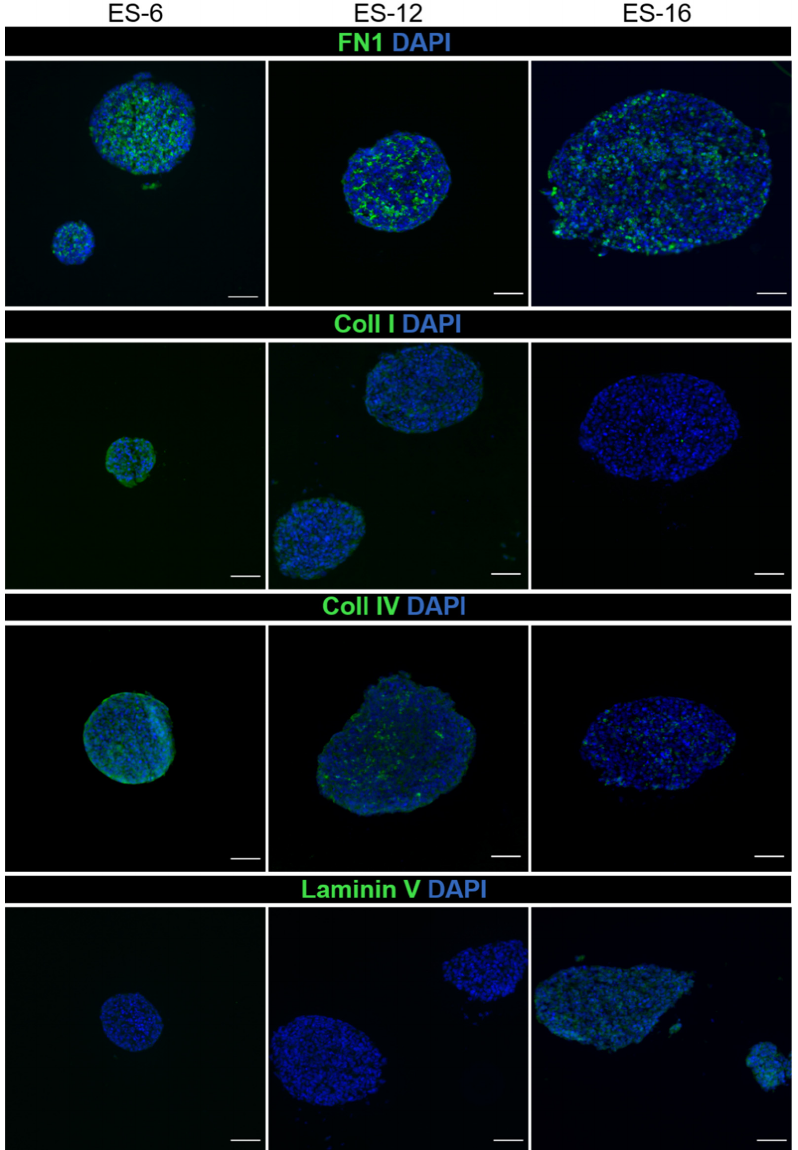
Figure 4. Detection of extracellular matrix proteins after three weeks of encapsulated spheroid culture. Immunofluorescence detection of fibronectin, collagen I, collagen IV and laminin (green) in encapsulated spheroids generated from three distinct ES-PDX; nuclei were counterstained with DAPI (blue). Scale bar: 50 μ m.